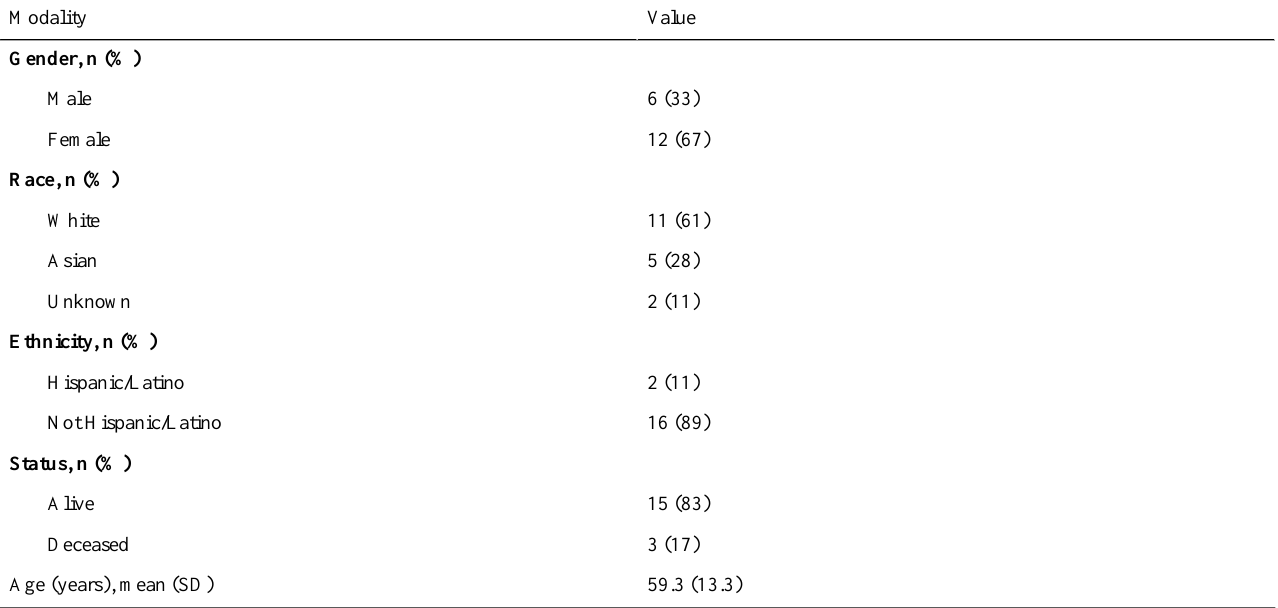
Table 2. Cohort demographics and clinical information. Demographic breakdown of clinical pilot